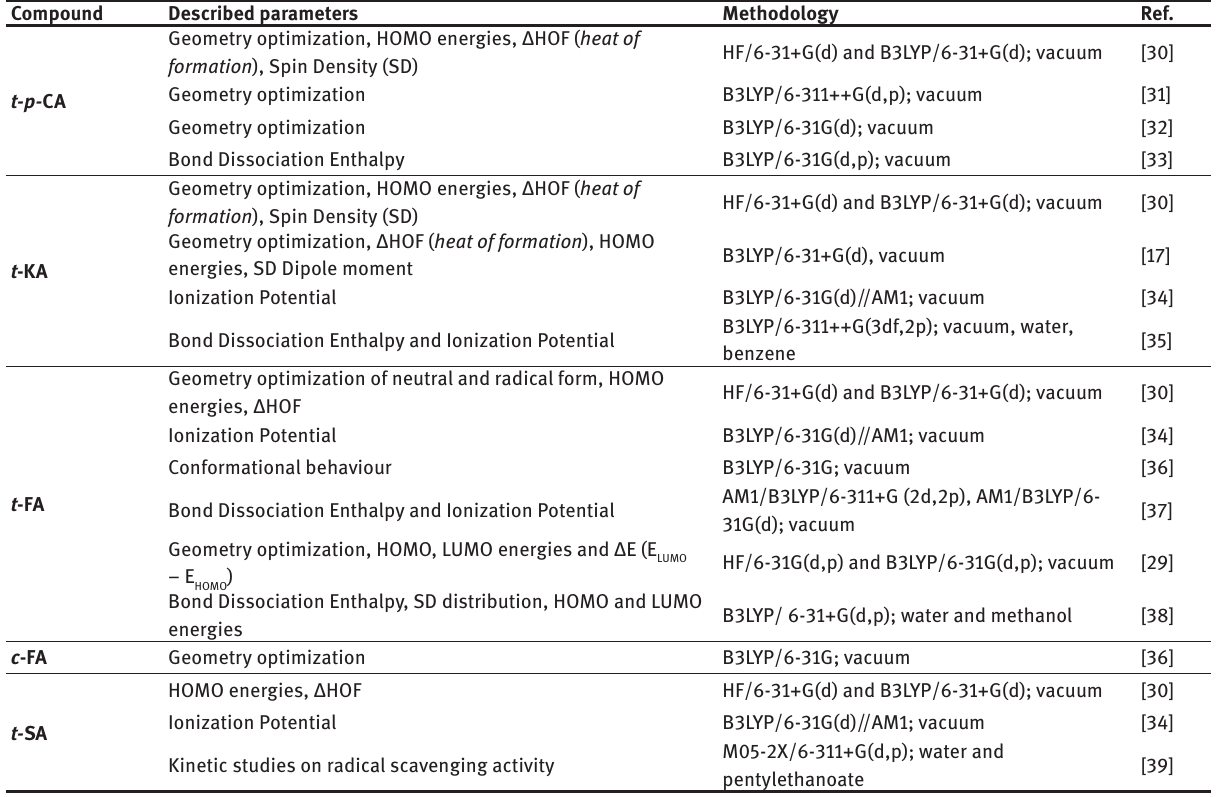
Table 1: Summary of the previous theoretical studies about hydroxycinnamic acids. Compound Described parameters